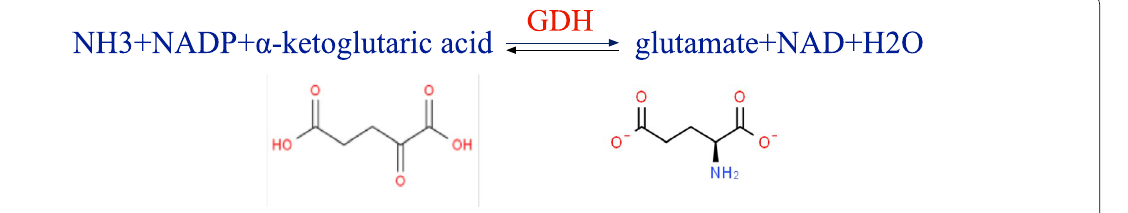
Fig. 5 Reversible reaction of glutamate and a-ketoglutaric acid